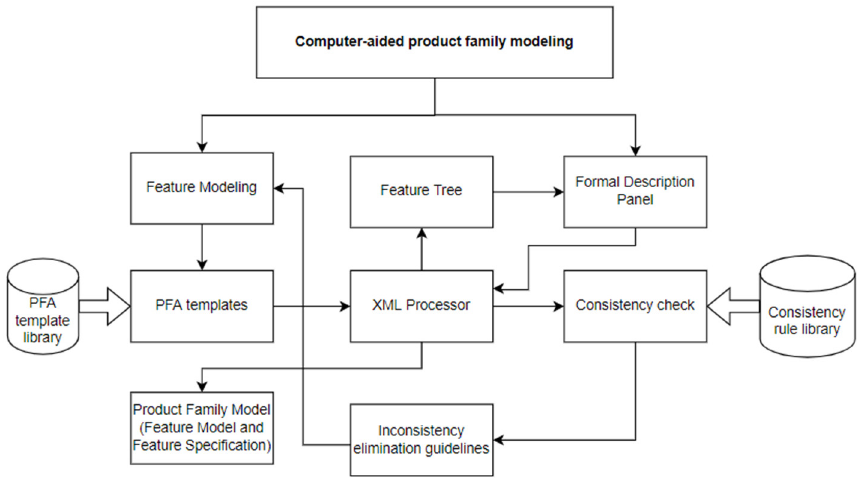
Figure 2. Design of Our Supporting Tool.